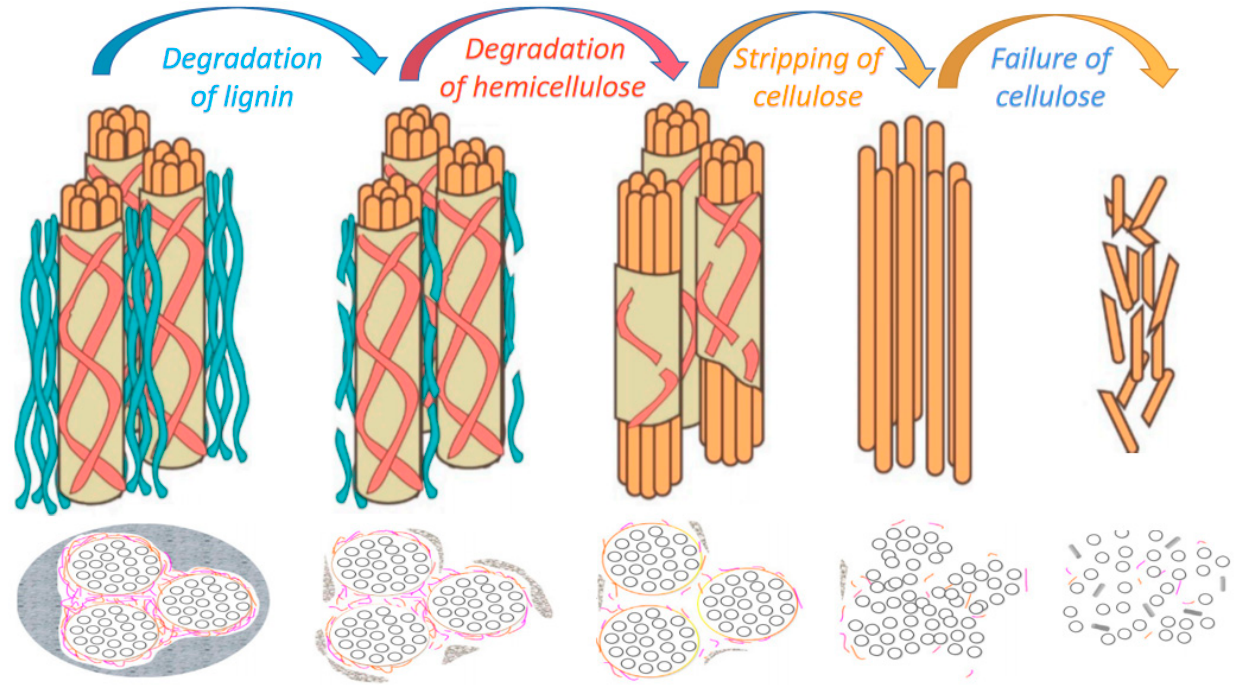
Figure 5. The alkaline degradation mechanism of PFs